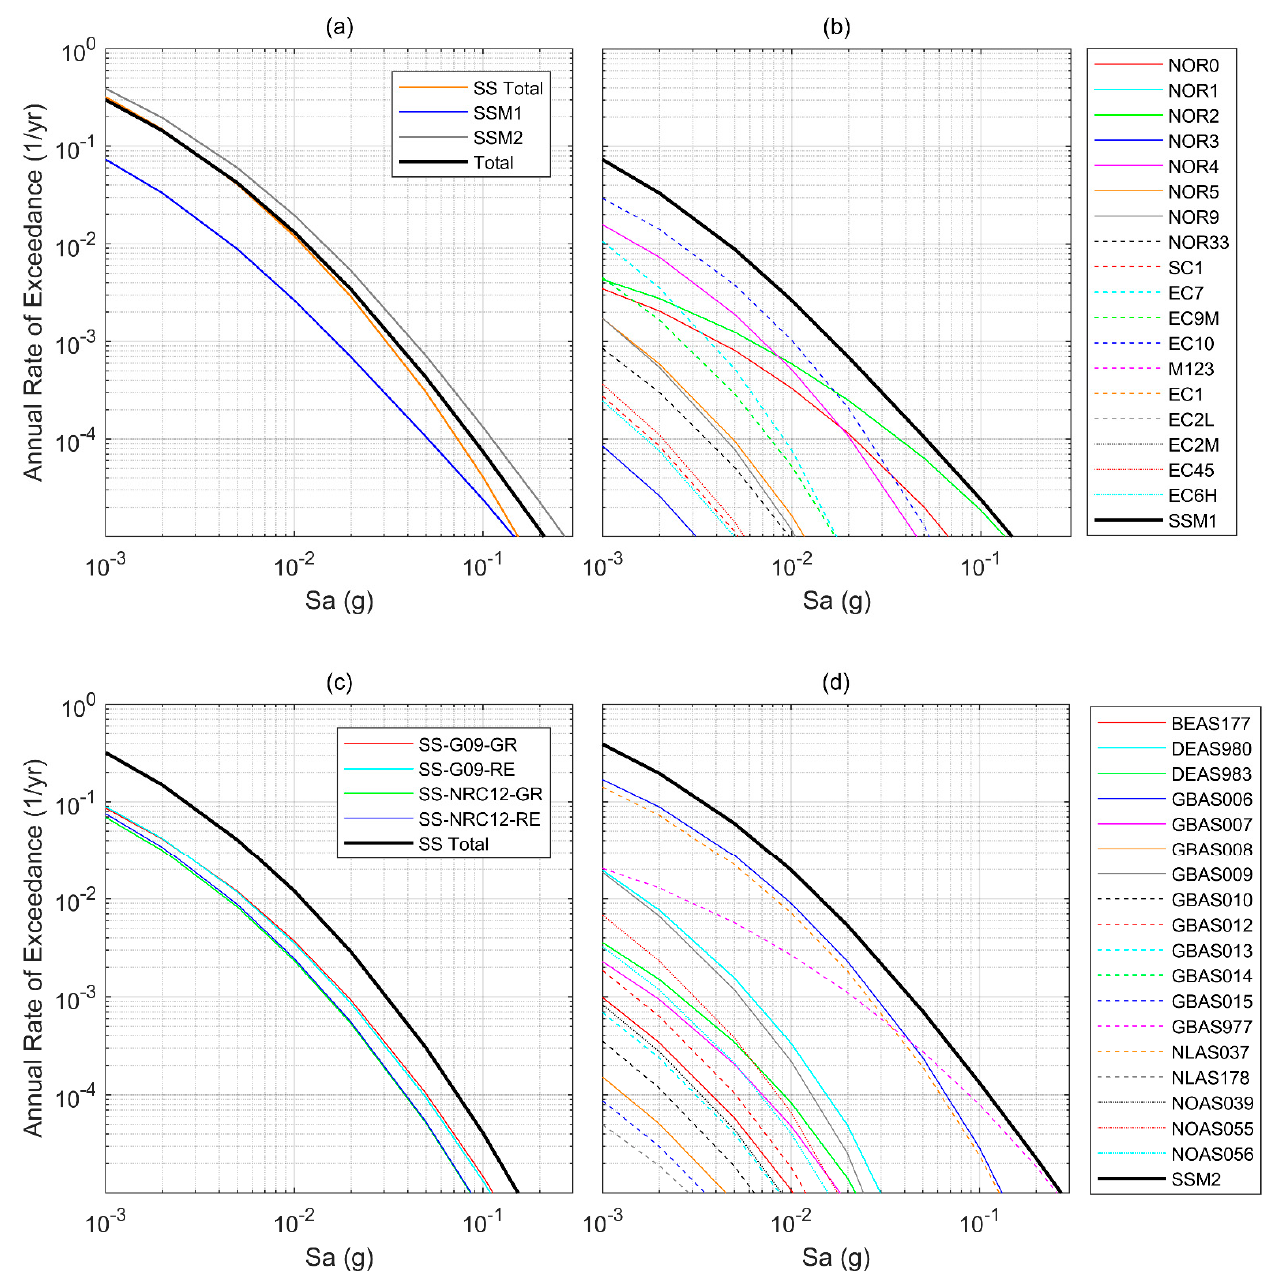
Figure 6. Results for PGA on rock showing ( a ) the unweighted hazard curves for the three source models versus the total mean hazard curve, ( b ) the contribution of the different source zones to SSM1, ( c ) the contribution of the different smoothed seismicity models to the total hazard for the smoothed seismicity models (SS Total), and ( d ) the contribution of the different source zones to SSM2.